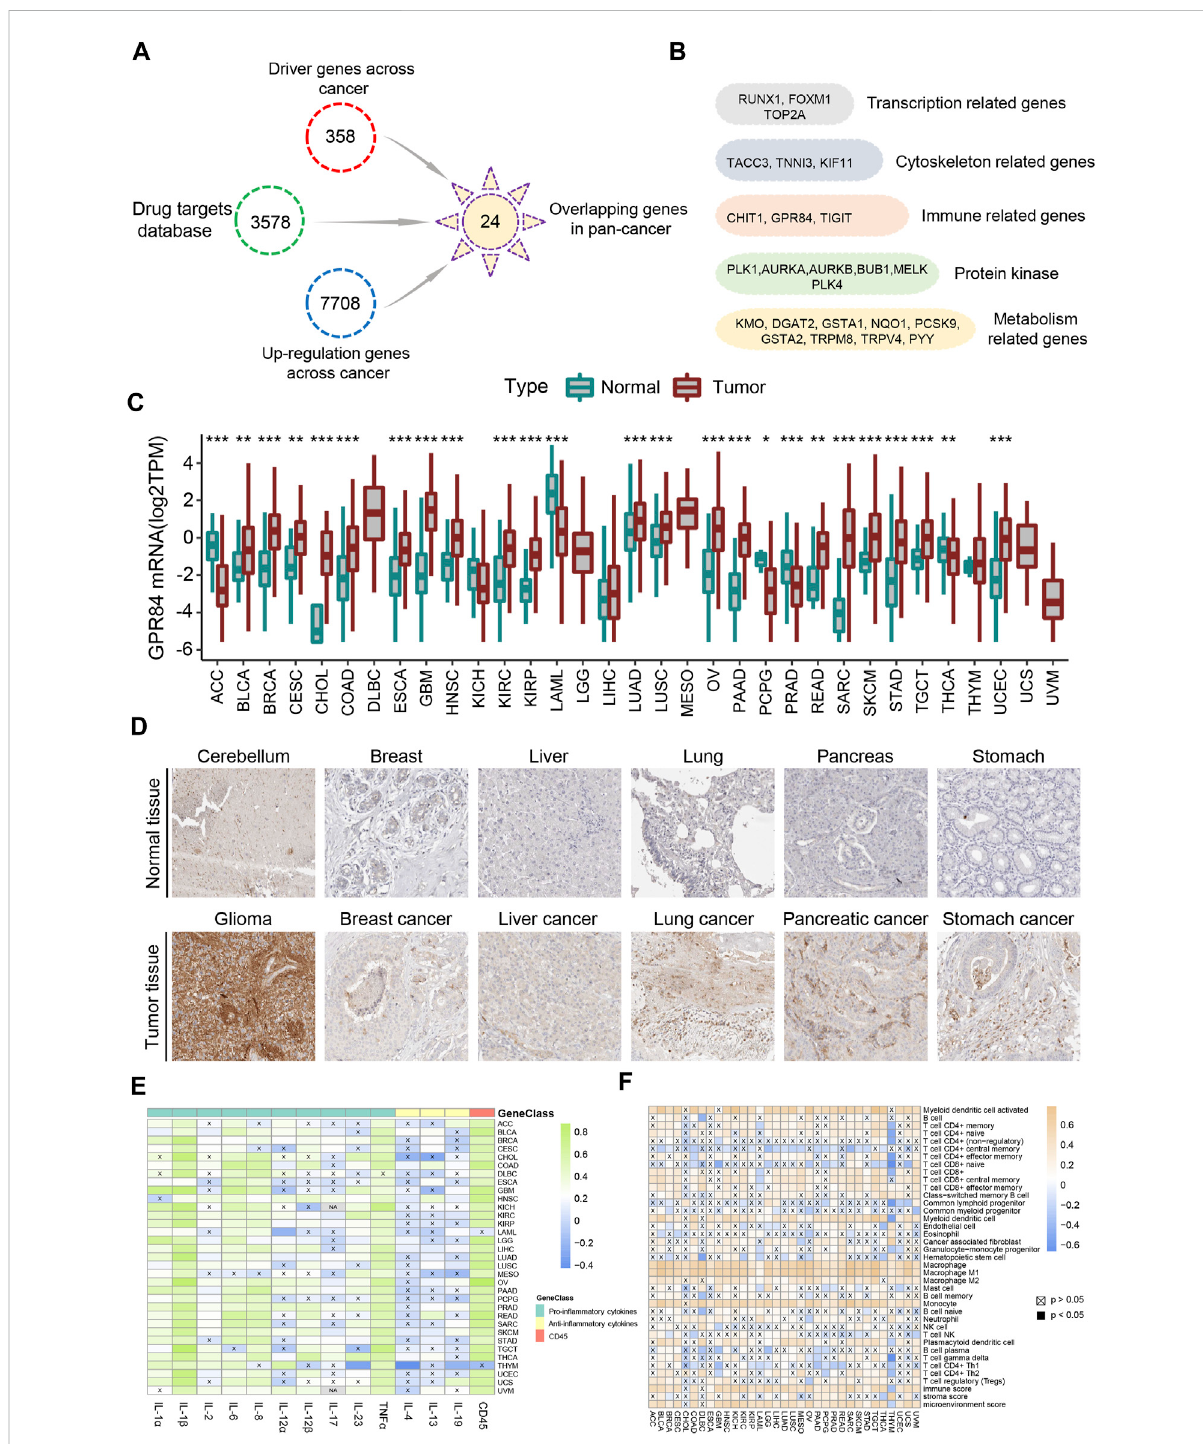
FIGURE 5 Screening of drug targets based on the immune index de fi ned by CD45 expression. (A) Screening fl owchart of potential drug targets based on theimmuneindexbetweenthenormaltissueandthehighorlowimmuneindexgroupsacrosscancers. (B) 24commonpotentialdrugtargetsacross different cancers divided into fi ve categories: transcription-related genes, cytoskeleton-related genes, immune-related genes, protein kinase and metabolism-related genes. The mRNA (C) and protein (D) levels of GPR84 in normal tissue and tumor tissue across cancers from the Human Protein Atlas. Analysis of correlation between the expression level of GPR84 and levels of in fl ammatory factors (E) and immune cells (F) across cancers. * p < 0.05; ** p < 0.01 and *** p <